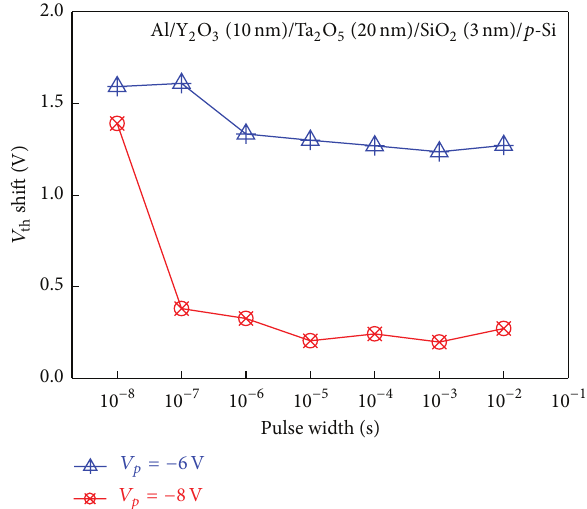
Figure 3: Programming characteristics of the Al/Y 2 O 3 /Ta 2 O 5 / SiO 2 /Si transistors. Figure 4: Erase characteristics of the Al/Y 2 O 3 /Ta 2 O 5 /SiO 2 /Si tran-